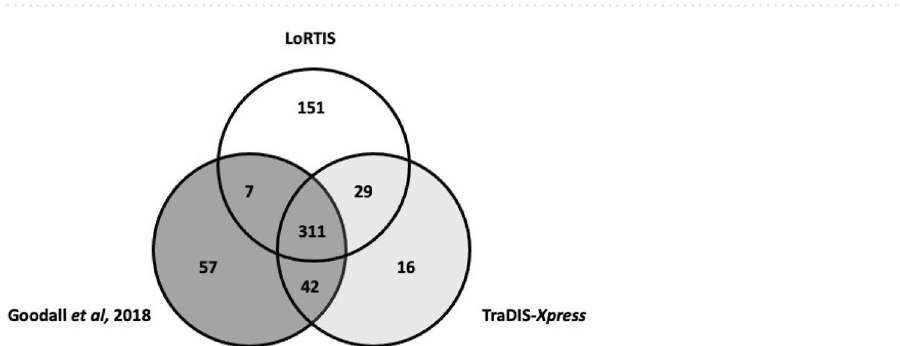
Figure 4. Putative essential genes identified using three different transposon insertion sequencing methods. Venn diagram showing the number of putative essential genes identified from three different transposon insertion sequencing sources: LoRTIS, TraDIS- Xpress and TraDIS 7 . Of these, 311 putative essential genes were common to all three data